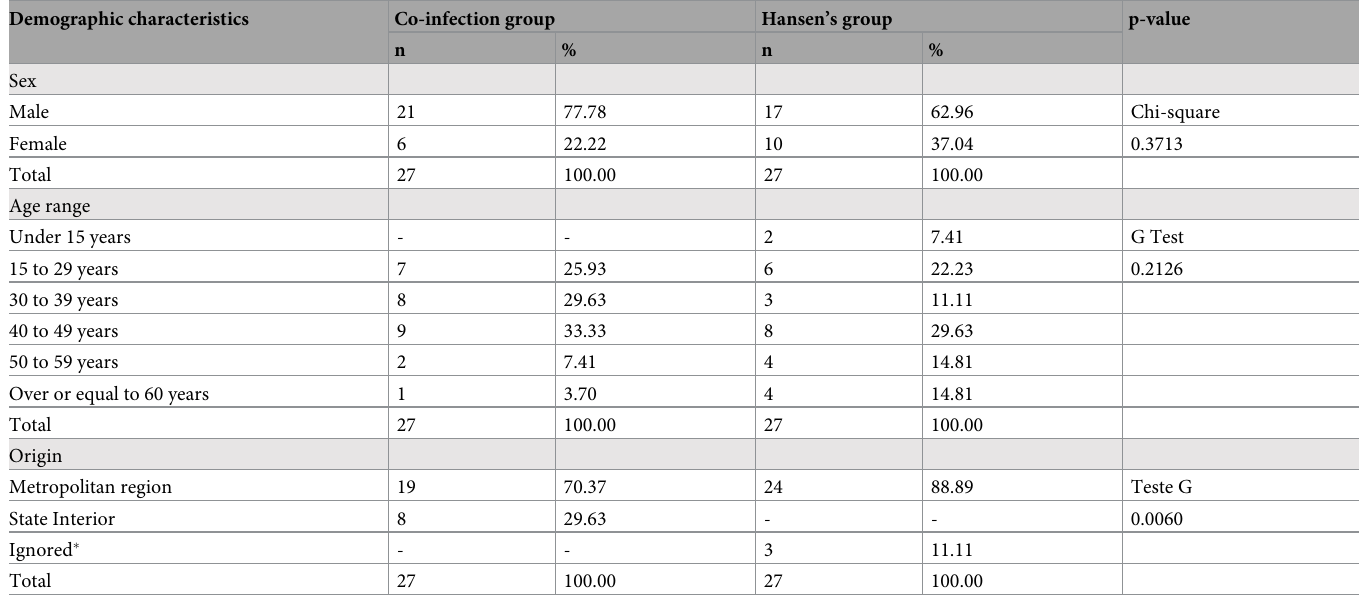
Table 1. Demographic characteristics of leprosy patients with and without HIV coinfection treated at a referral center, Bele´m—Para´, from 2003 to 2017. Demographic